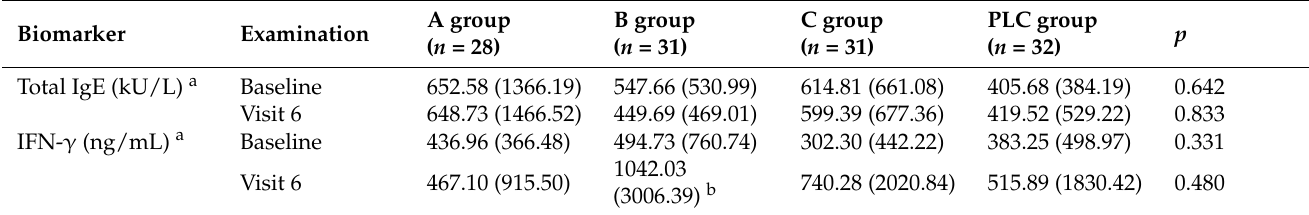
Table 7. Serum biomarker and sensitization levels at baseline and at the end of treatment #